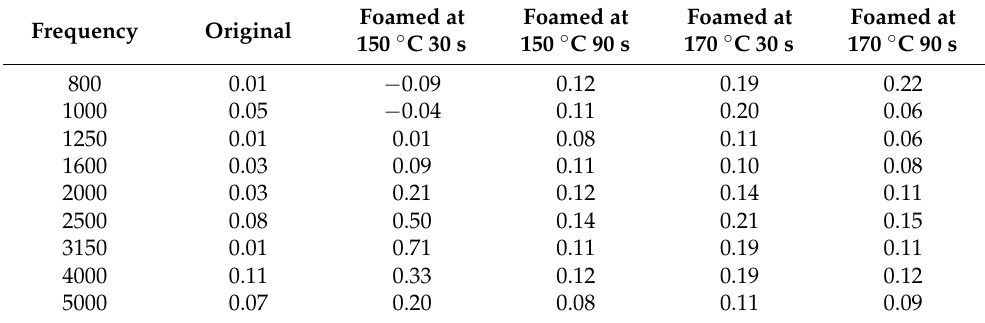
Figure 9. Sound absorption coefficient–frequency curve of microcellular foamed ceramic urethane obtained using an impedance tube (high-frequency). Table 6. Results of SAC for measuring at high-frequency.